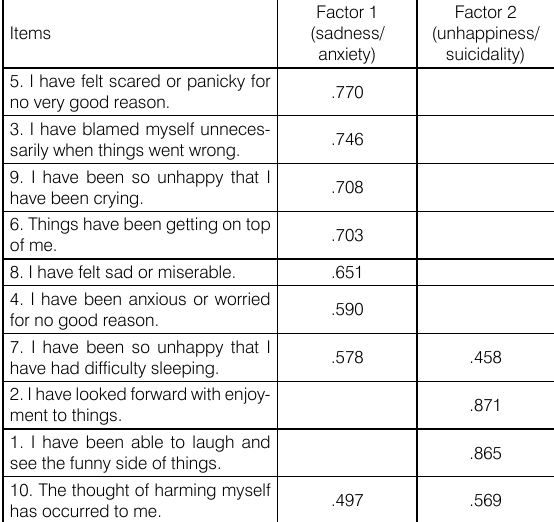
Table 4. Factor loadings for EPDS-R items based on PCS with varimax